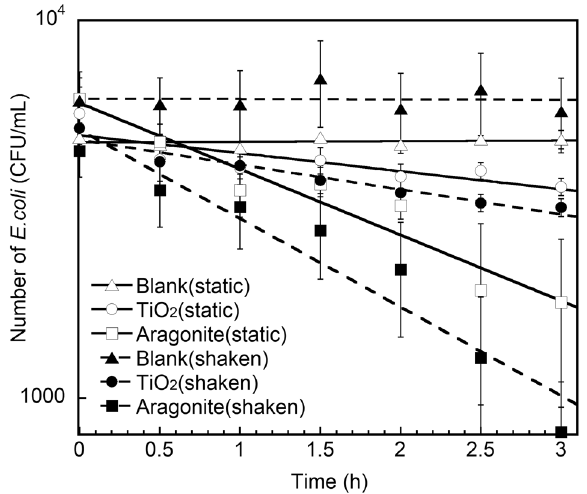
Figure 2. Over time changes in the number of underwater E. coli on unmodified and CaCO 3 -modified TiO 2 ceramics under static and shaken conditions.